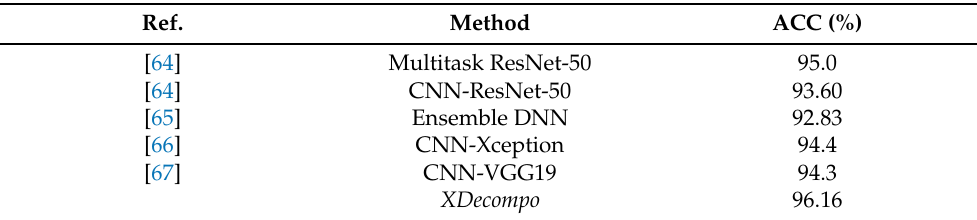
Table 10. Comparison between the result obtained by XDecompo and different approaches that used the same labelled dataset for the classification of CRC